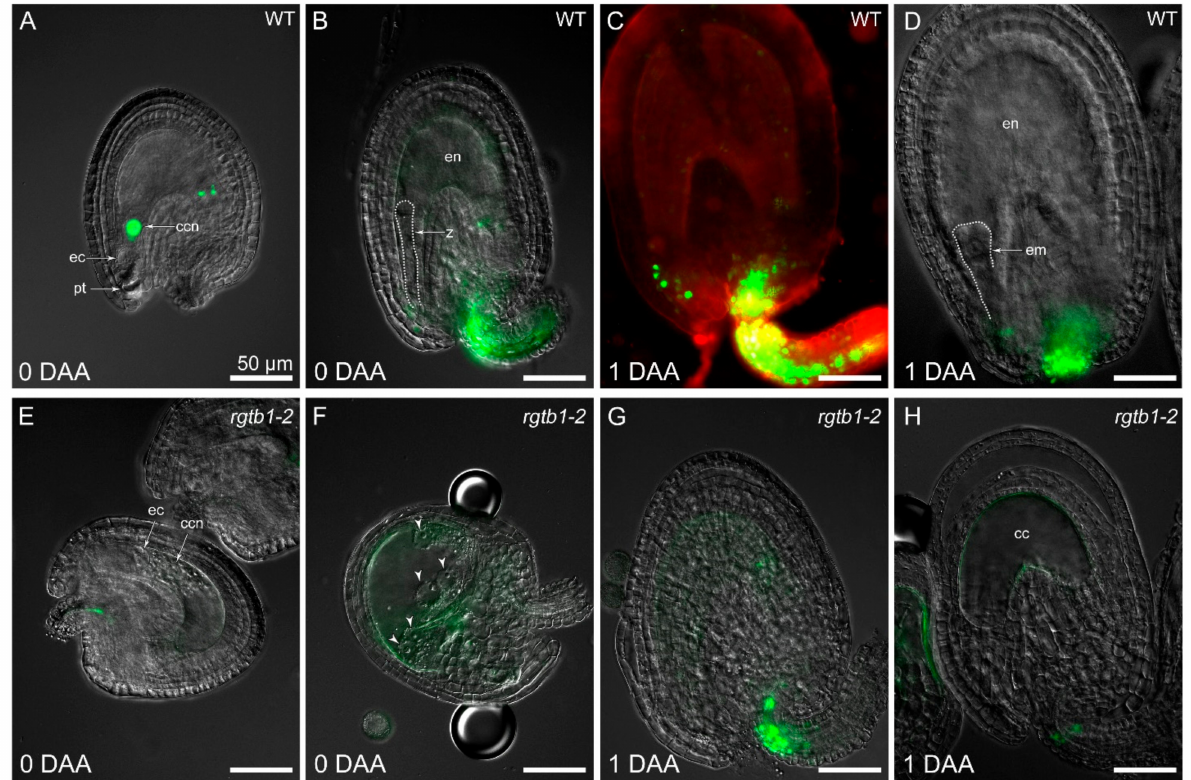
Figure 4. Auxin signaling is different in WT and rgtb1 ovules after open pollination. ( A ) signal of auxin reporter pDR5rev :3xVenus-NLS (green) is present inside the embryo sac, but not in the sporophytic tissues surrounding it in WT ovules. ( B – D ) Shortly after fertilization in WT plants, the pDR5rev: 3xVenus-NLS signal appears in the funiculus and chalaza, but is no longer present in the developing endosperm or embryo. ( E – H ) in rgtb1 ovules, the pDR5rev: 3xVenus - NLS signal is absent or very weak in the embryo sac and the sporophytic tissues of the ovule before ( E ) and after anthesis ( F – H ), although the formation of the autonomous endosperm is sometimes obvious ( F ); white arrowheads point to the AE nuclei. ( C ) CSLM image, the pDR5rev :3xVenus-NLS signal (green) are counterstained with FM4-64 (red) to contour the cells, all the other images were made using fluorescence microscopy, showing the pDR5rev :3xVenus-NLS signal (green). The scale bar of 50 µ m in ( A ) is the same in all images. Abbreviations: cc—central cell, ccn—central cell nucleus, ec—egg cell, pt—pollen tube, en—endosperm, z—zygote, em—embryo, DAA—day after